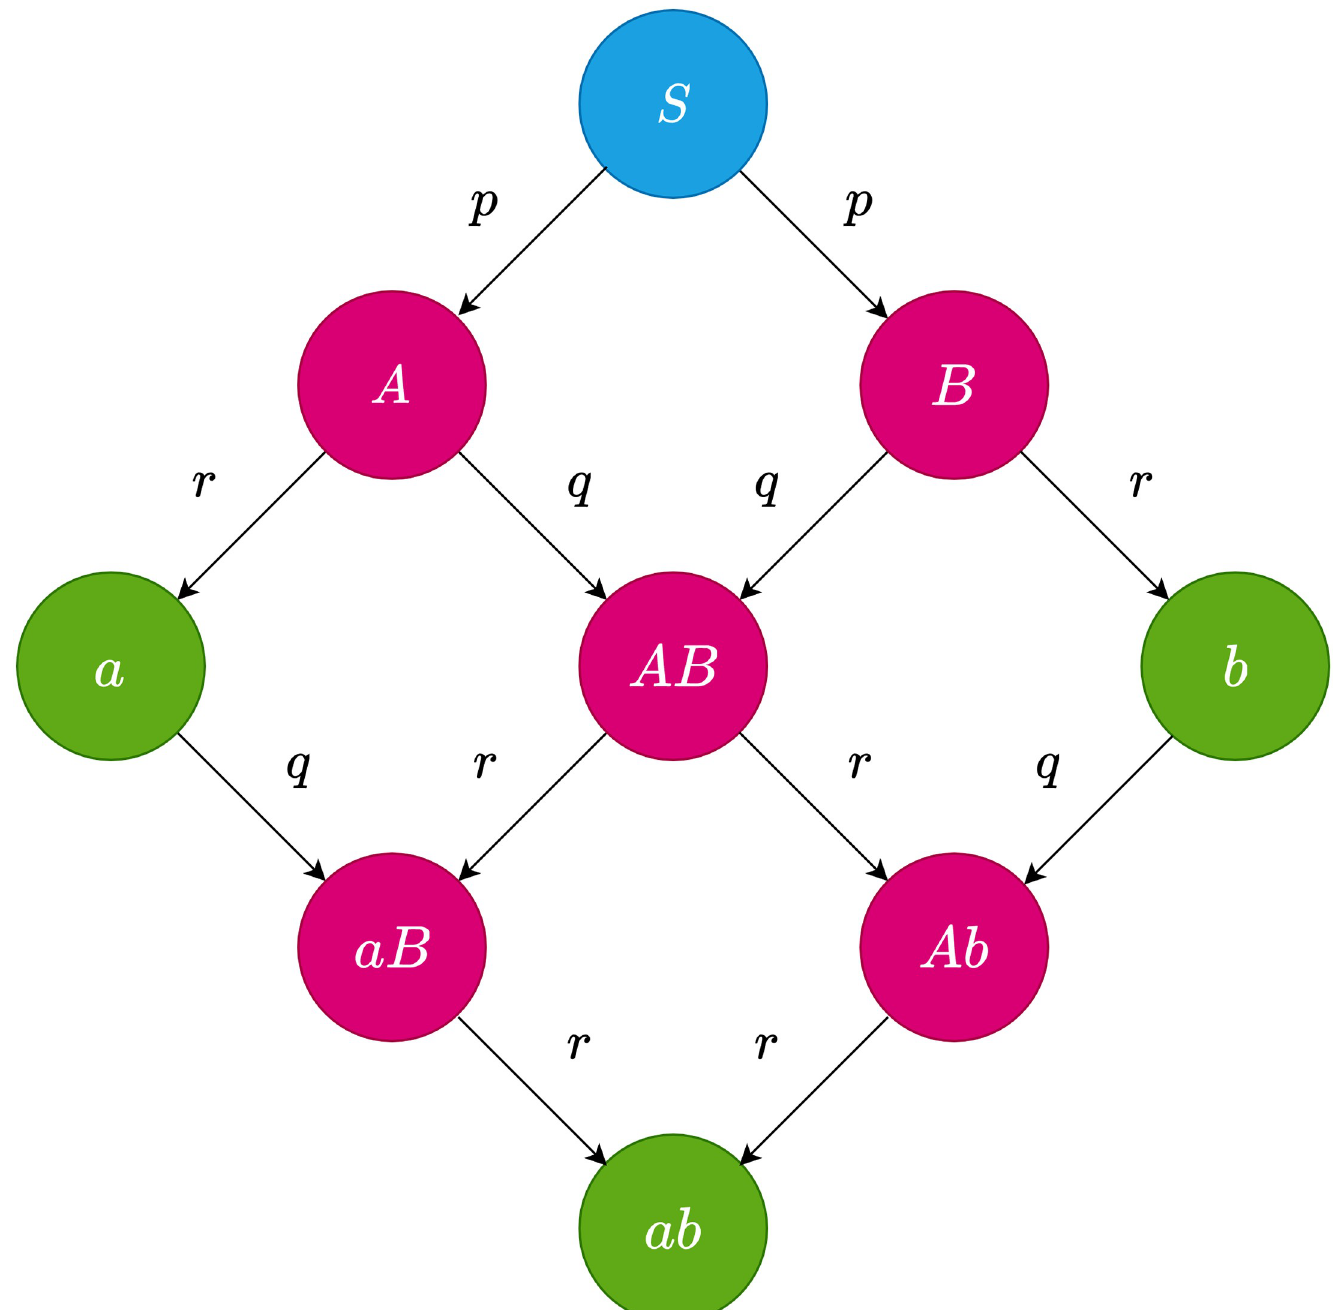
Fig 2. Different states in the SIR-SIR model [18] and the probabilities of switching between states. Capital letters denote the infectious state regarding one disease, small case letters denote the recovered states. Each arrow indicates a transition with a certain probability. State S illustrated by color blue, denotes the agents’ initial states. Blocks illustrated by color pink and green, respectively represent infectious and recovered states.